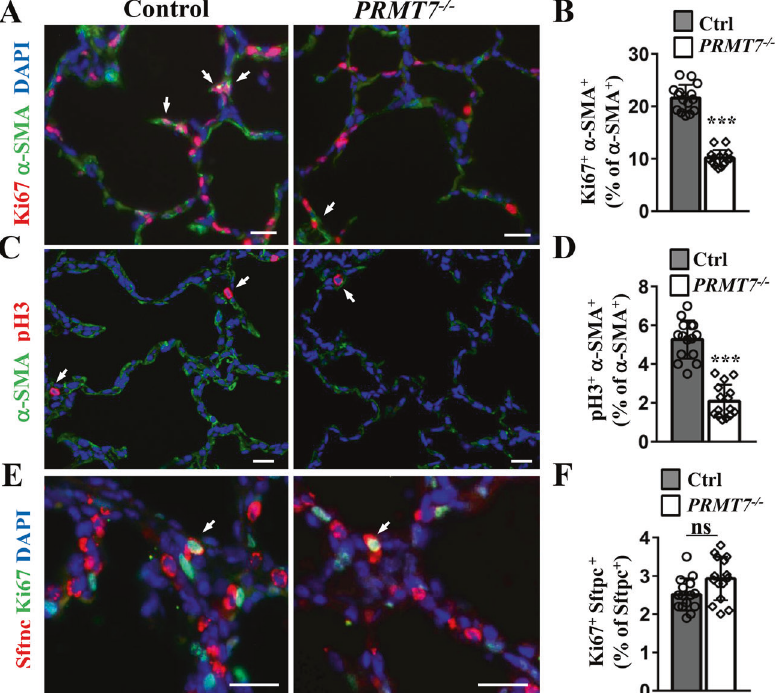
Fig. 3 Reduced proliferation of lung alveolar myo fi broblasts in PRMT7 − / − mice. A , B Ki67 and α -SMA co-immunostaining showing the reduced myo fi broblasts proliferation in PRMT7 − / − lungs. Arrows indicate Ki67 and α -SMA double-positive cells. Scale bars: 20 μ m. proliferating myo fi broblasts were quanti fi ed as in ( B ). C Proliferating myo fi broblasts were detected by α -SMA and pH3 co-immunostaining in control and PRMT7 − / − lungs at P6. Arrows indicate pH3 and α -SMA double-positive cells. Scale bars: 20 μ m. D Quanti fi cation of α -SMA and pH3 double- positive cells. E , F Ki67 and Sftpc co-immuno fl uorescence staining showing normal alveolar type II (ATII) cell proliferation in PRMT7 − / − lungs. Arrows indicate Ki67 and Sftpc double-positive cells. Scale bars: 20 μ m. Proliferating ATII cells were quanti fi ed as in ( F ). B , D , F Only the number of α -SMA + cells located within the alveolar region were calculated (excluding parabronchial and vessel associated α -SMA + cells). Data were shown as mean ± SD. Fifteen fi elds from at least six mice per genotype were quanti fi ed. ns not signi fi cant, *** P < 0.001 (Student ’ s t